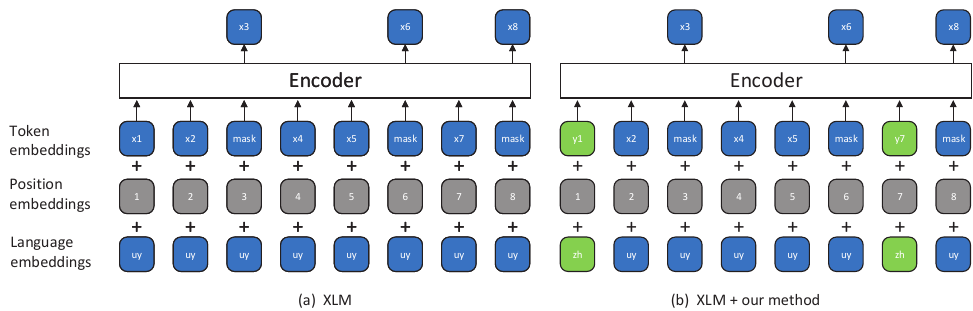
Figure 1. The examples of the cross-lingual language model (XLM) and our method based on XLM. ( a ) XLM randomly masks some tokens and then predicts the masked tokens by unmasked tokens and ( b ) our method based on XLM replaces some unmasked tokens with its translation tokens.